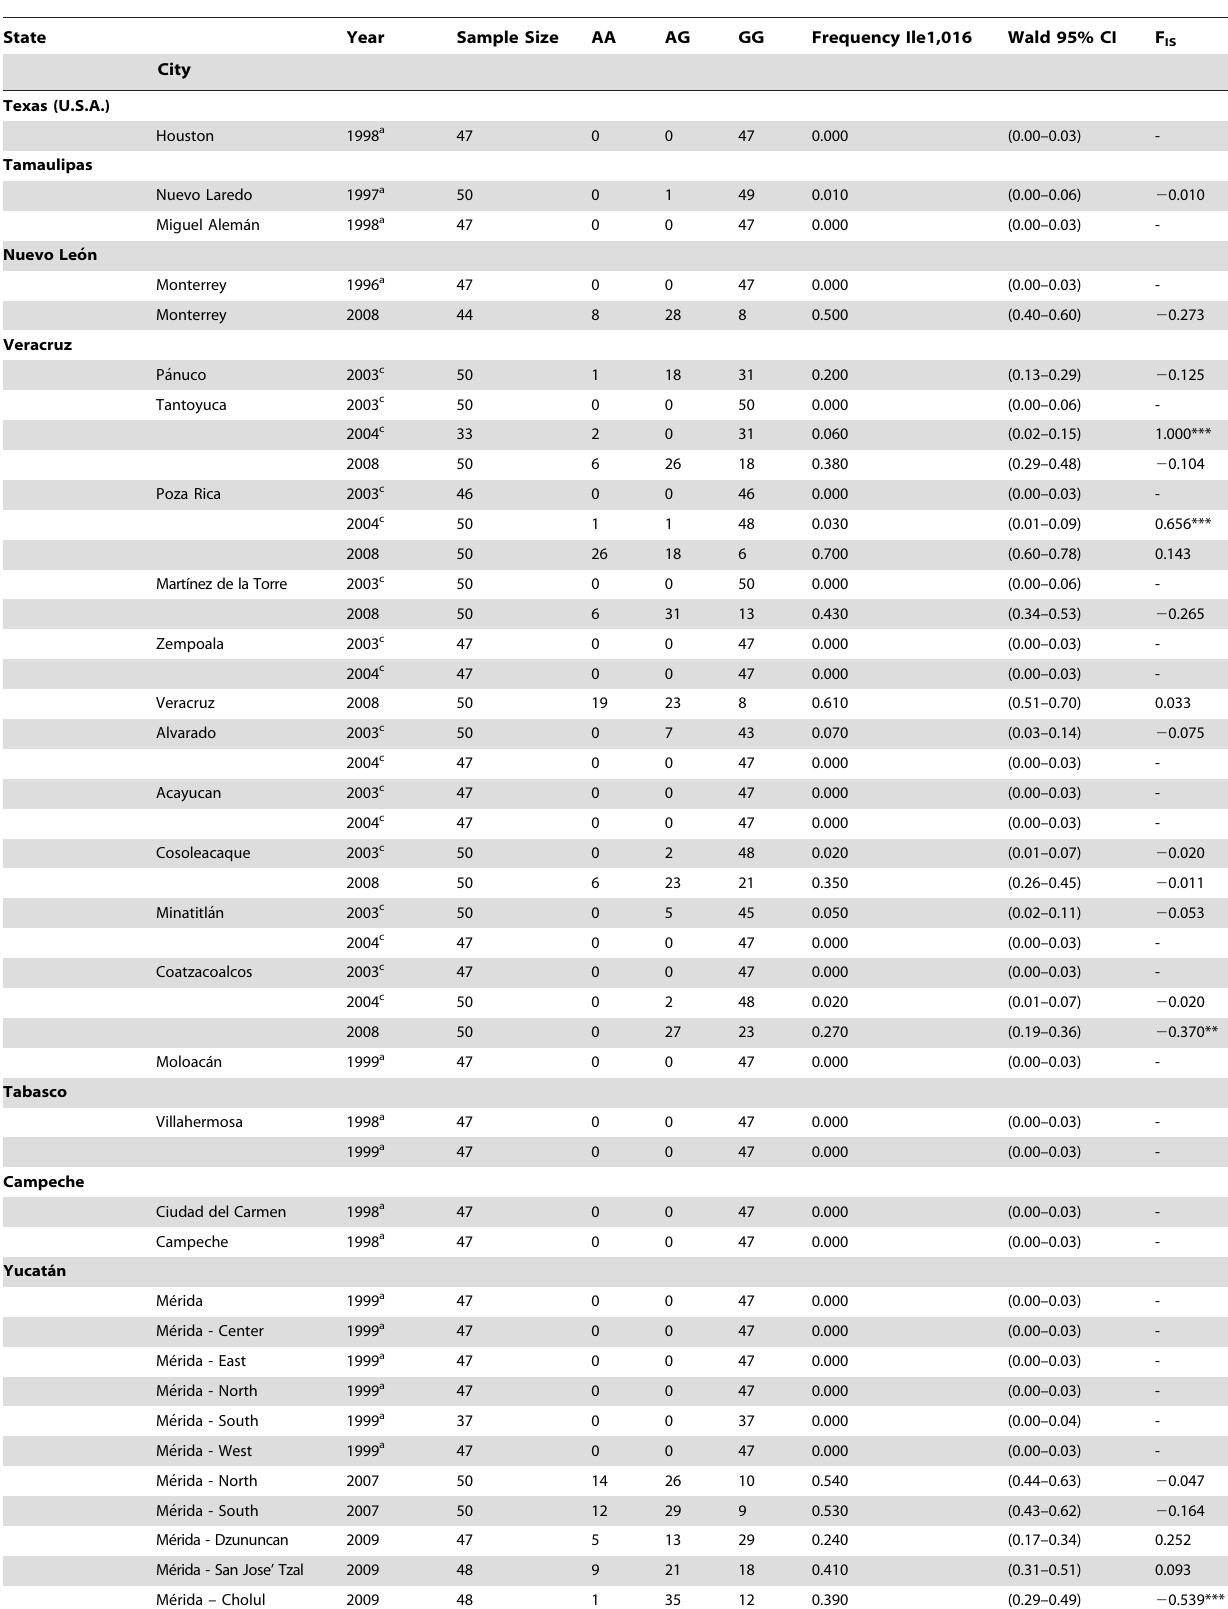
Table 1. Locations, collection years, sample sizes and numbers of mosquitoes of each genotype.